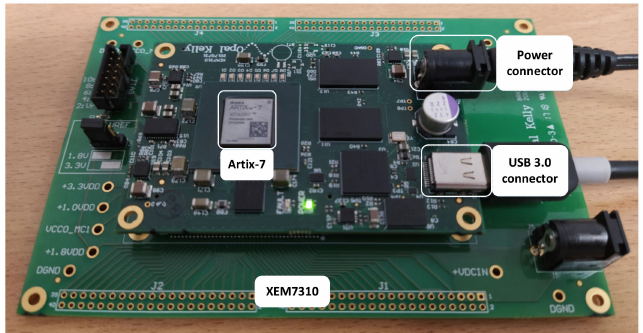
Figure 4. Evaluation board of the proposed TDC.